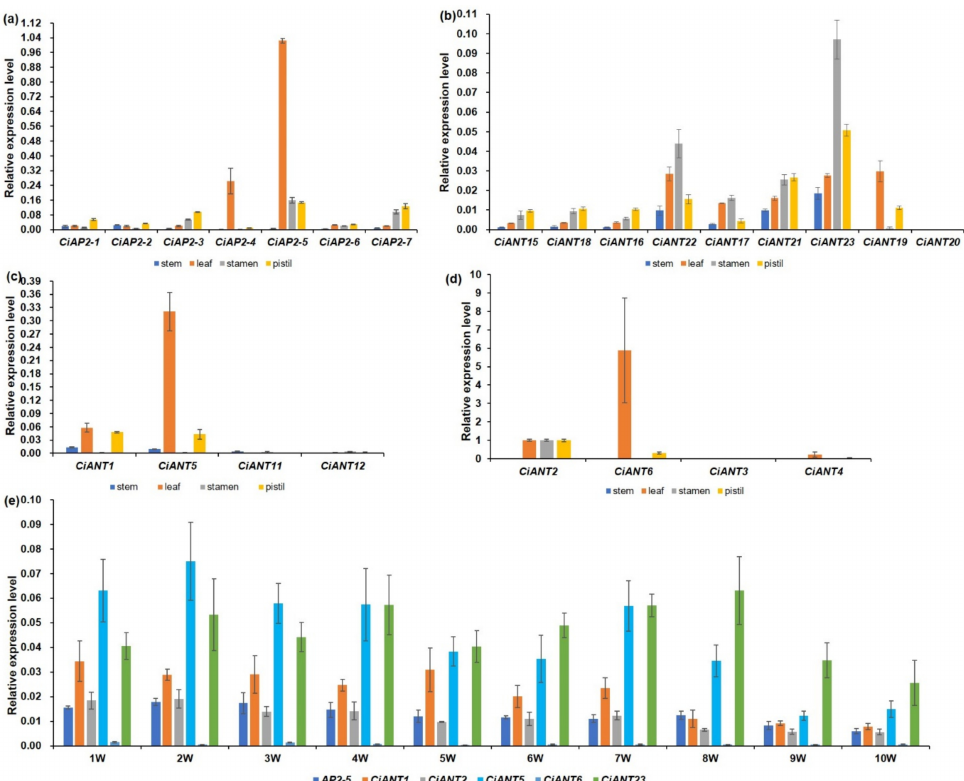
Figure 5. The expression analysis of pecan AP2 subfamily genes. ( a – d ) The expression of AP2 subfamily genes in pecan stems, leaves, stamens and pistils. ( e ) The expression of CiAP2-5 , CiANT1 , CiANT5 , CiANT6 and CiANT23 in developing pecan fruits after pollened 1 to 10 weeks, respectively. Pecan actin gene ( OF23284 ) was used as the internal reference gene. Error bars indicate SD. Each reaction represents three technical